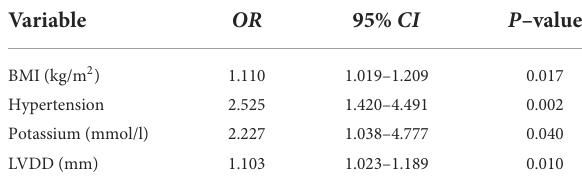
TABLE 2 Factors that contribute to the increase of